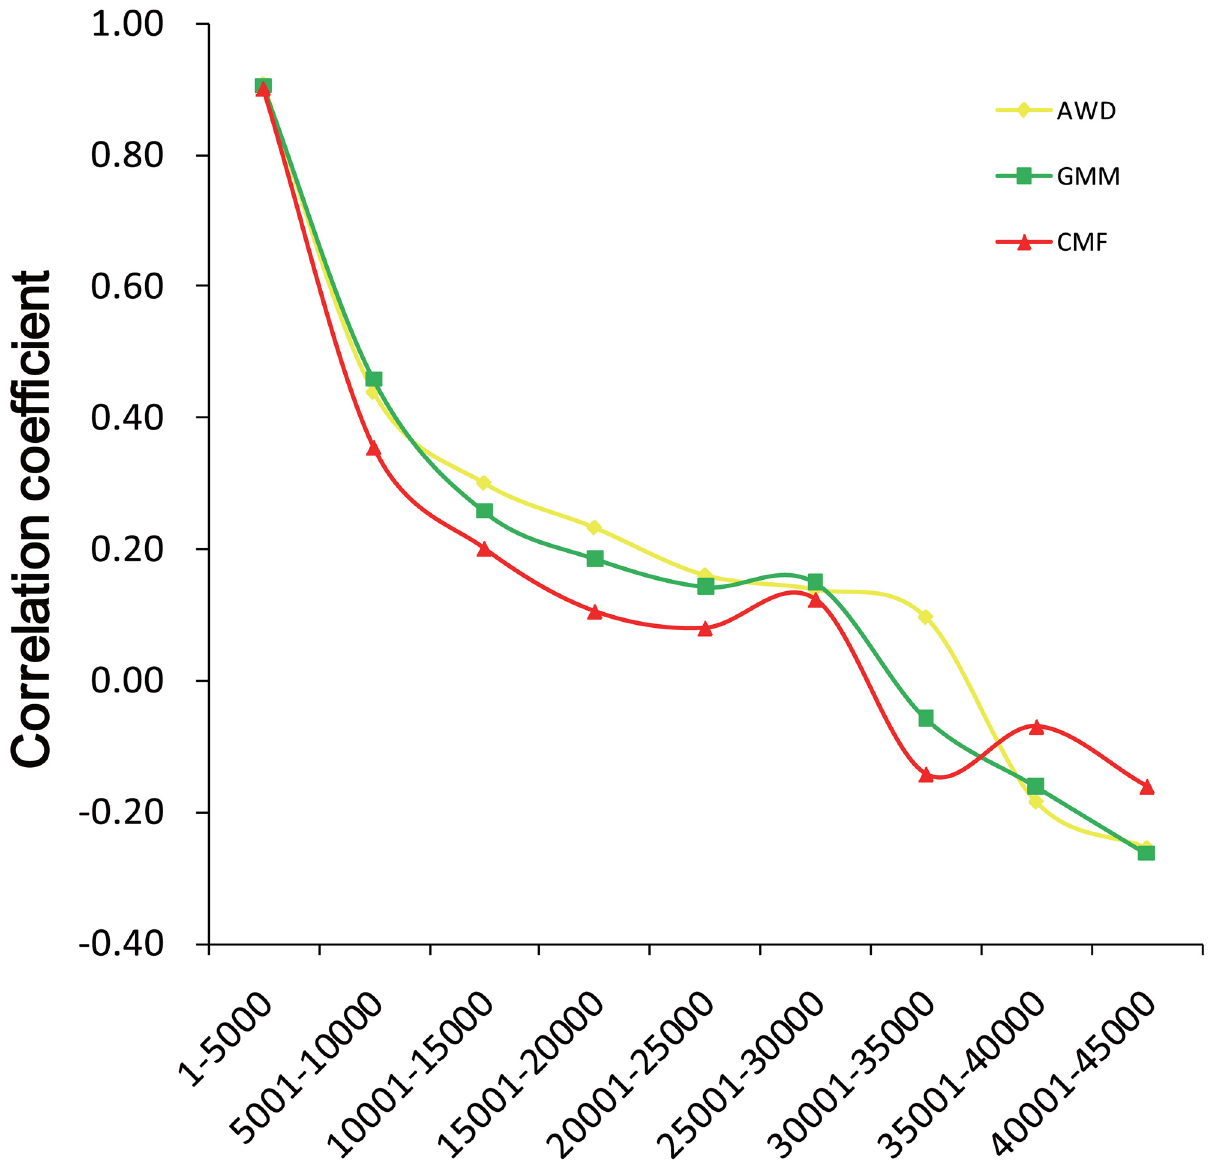
Fig 4. Correlation between LSBL and d i